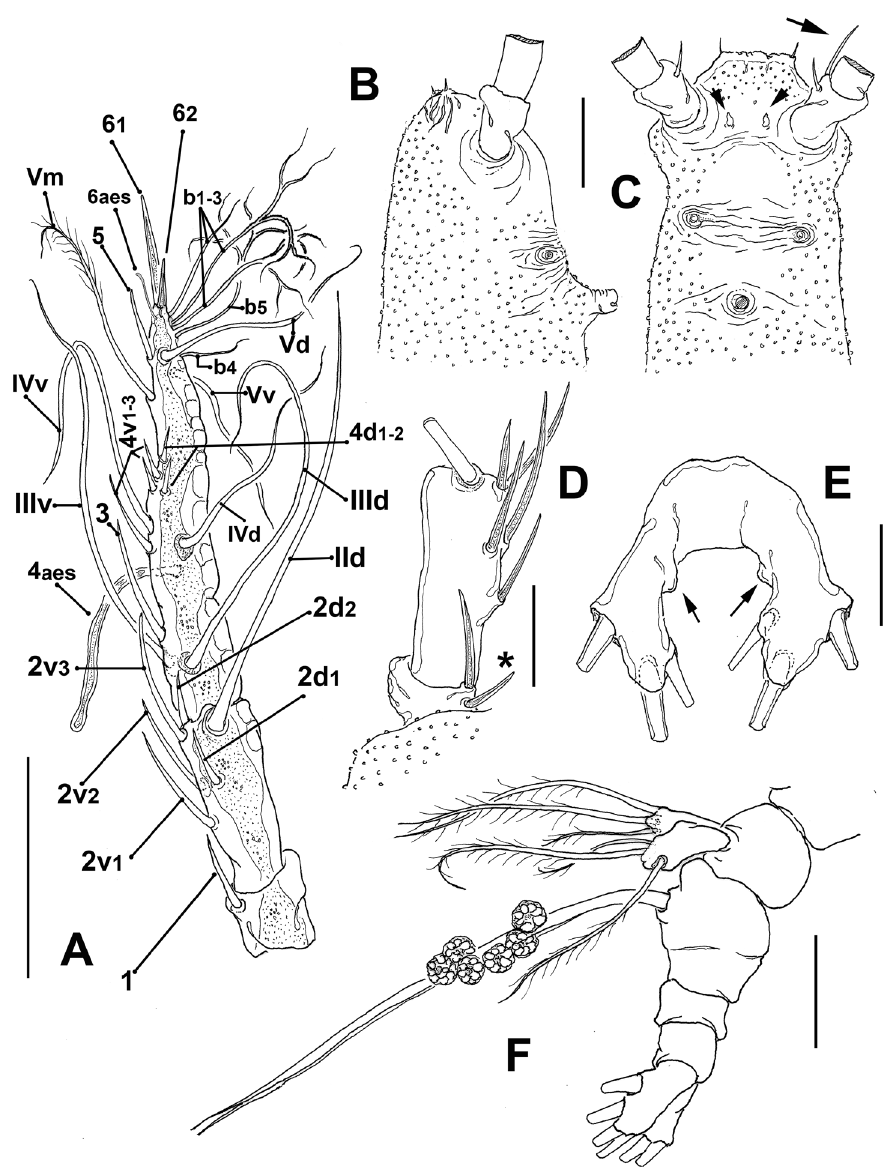
Figure 3. Monstrillopsis planifrons sp. n., adult female holotype from the Canadian Arctic. A right anten- nule showing armature following nomenclature by Grygier & Ohtsuka (1995), dorsal view B cephalic area showing forehead and perioral ornamentation, lateral view C cephalic area, showing cuticular pro- cesses and ornamentation, ventral view, arrow shows supernumerary spiniform element on first segment of left antennule D detail of first and second antennulary segments of left antennule showing supernu- merary spiniform element on first segment (*) E fifth leg, ventral view showing small lobe-like processes on inner margin of exopodal (outer) lobes (arrowed) F urosome, showing fifth legs and ovigerous spines, lateral view. Scale bars: A 200 µm, B–F 100 µm, D–E 50